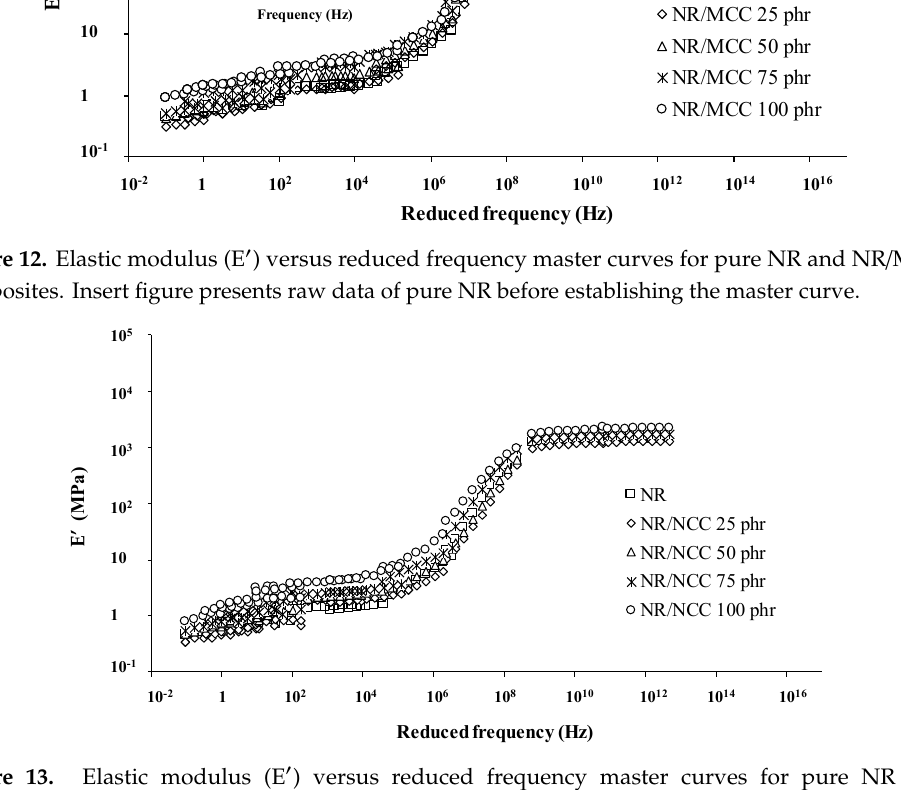
Figure 13. Elastic modulus (E’) versus reduced frequency master curves for pure NR and NR/NCC composites.